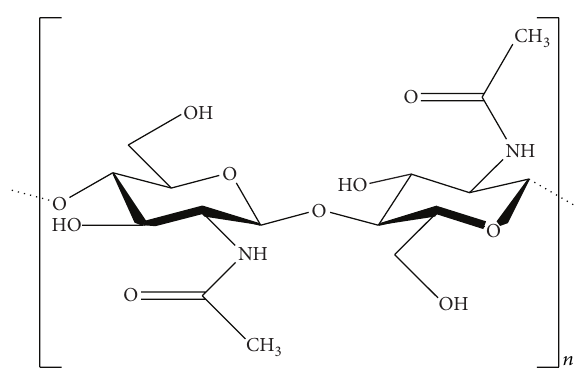
Figure 1: Chemical structure of the chitin